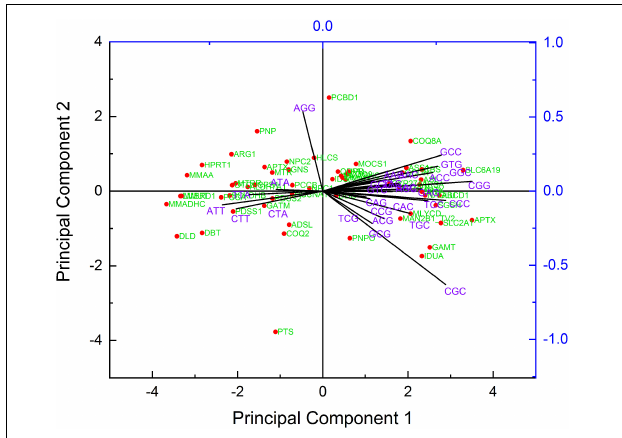
FIGURE 9 | A biplot depiction of PCA. Dots are representing the sequences, whilst arrows are showing codons. Eclipse showing a 95% confidence limit.